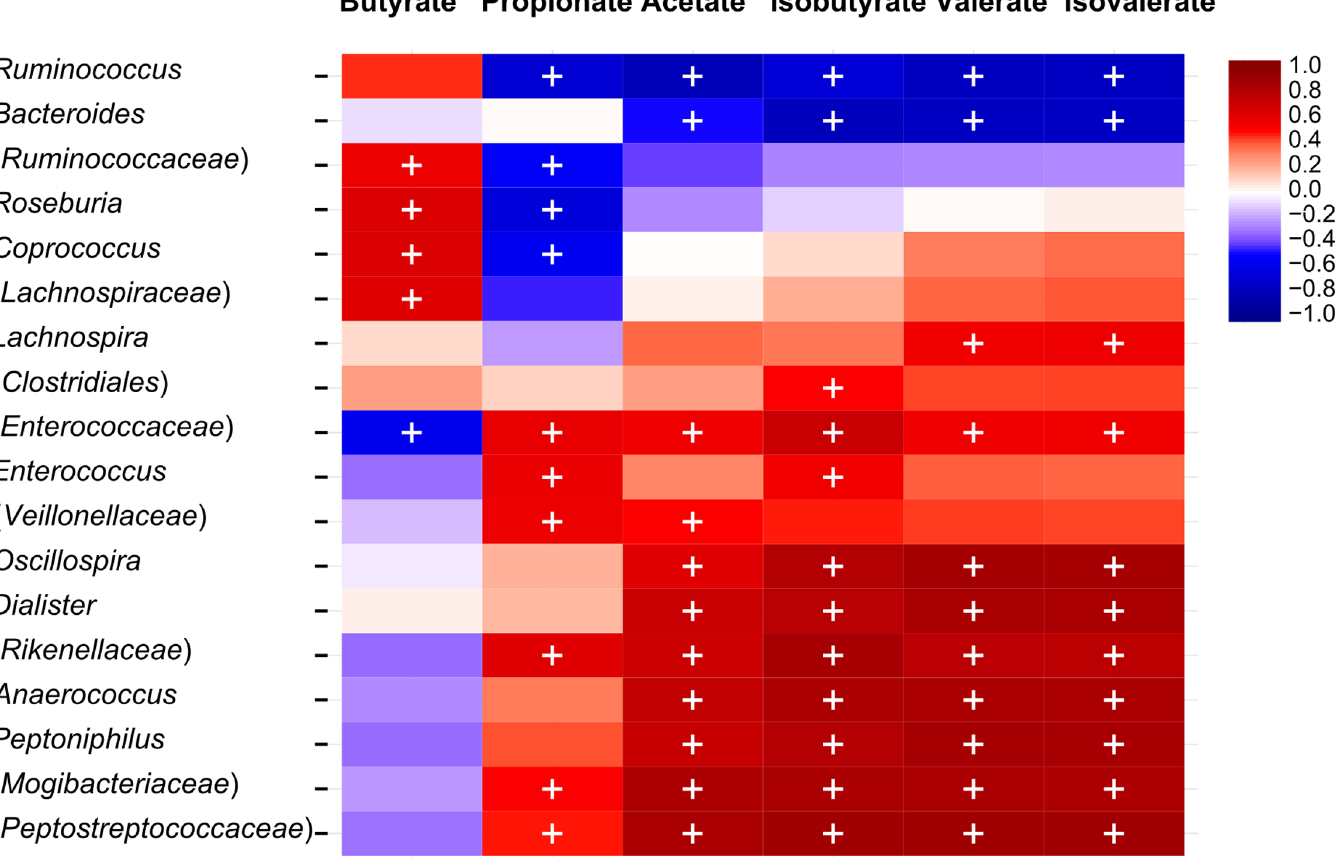
Fig 6. Correlations between genus-level phylogenetic groups and metabolites (SCFA, BCFA) of three last days at the end of stabilization period of model 2. The correlations, assessed by Spearman are indicated by either red (positive) and blue (negative), the significant correlations (q < 0.05) are indicated by ‘ + ’ . Only genus related phylotypes > 0.1% and with at least one significant correlation with metabolites are depicted. Parentheses indicate an unknown genus belonging to a family or